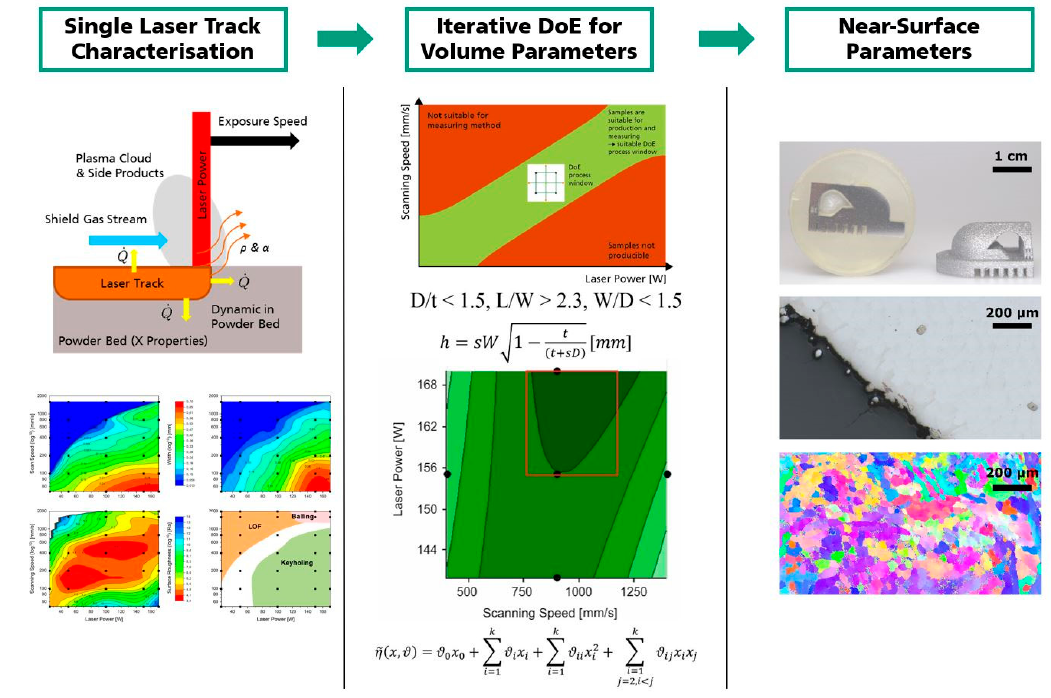
Figure 12. General outline of the approach representing the core steps.